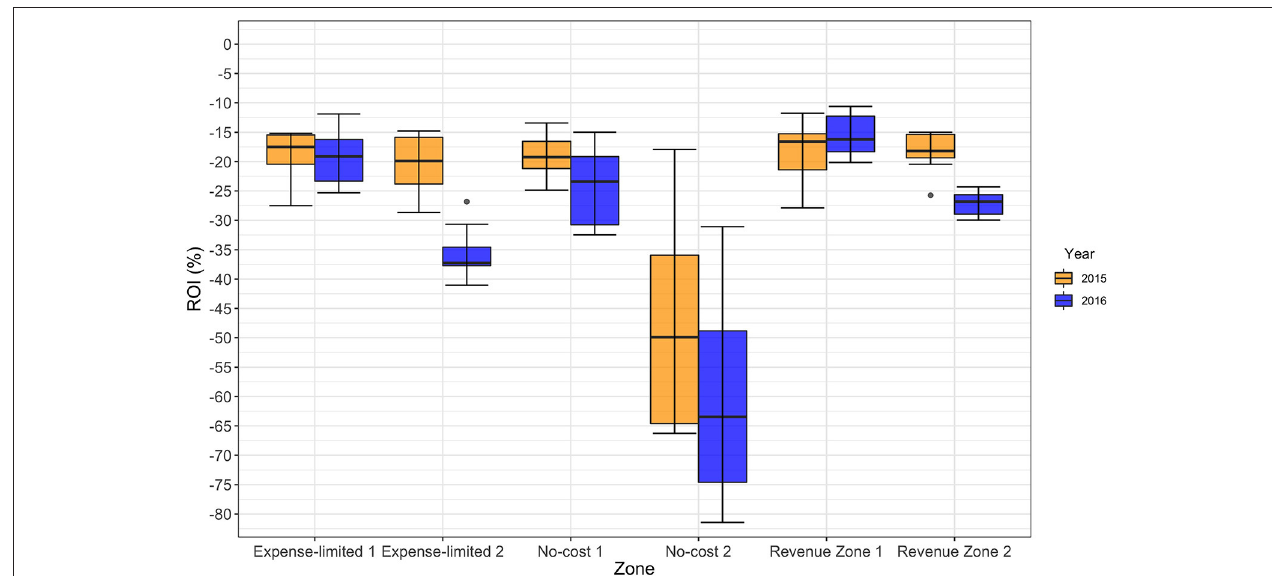
FIGURE 7 | Range of ROI values within each experimental zone during 2015 and 2016. No-cost zones were found to have the greatest range of variability resulting from the alternative N-treatments within each zone. Revenue zones were found to have the least variability compared to the No-cost and Cost-limited